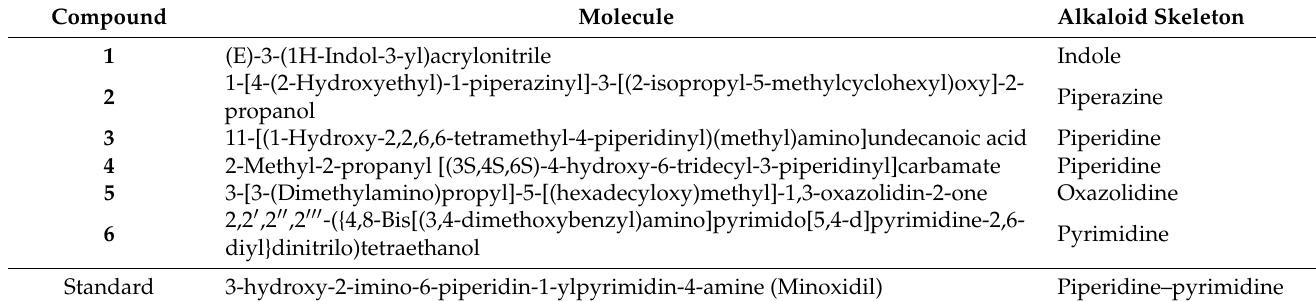
+++: high abundance, ++: abundant, +: low abundance (RT; Retention Time; m / z : mass-to-charge ratio). Table 6. The alkaloid compounds of FEA-3 with LC – MS/MS. Table 6. The alkaloid compounds of FEA-3 with LC–MS/MS.